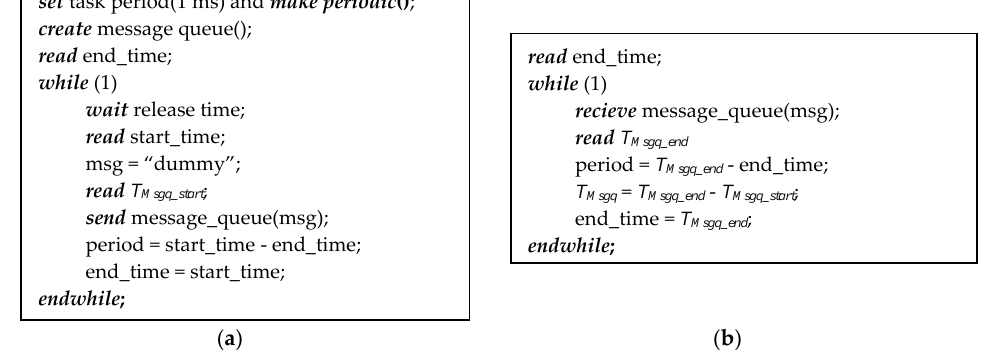
Figure 5. Pseudo code for measuring the elapse time of a message queue between two tasks: ( a ) high priority task (sender); ( b ) low priority task (receiver).